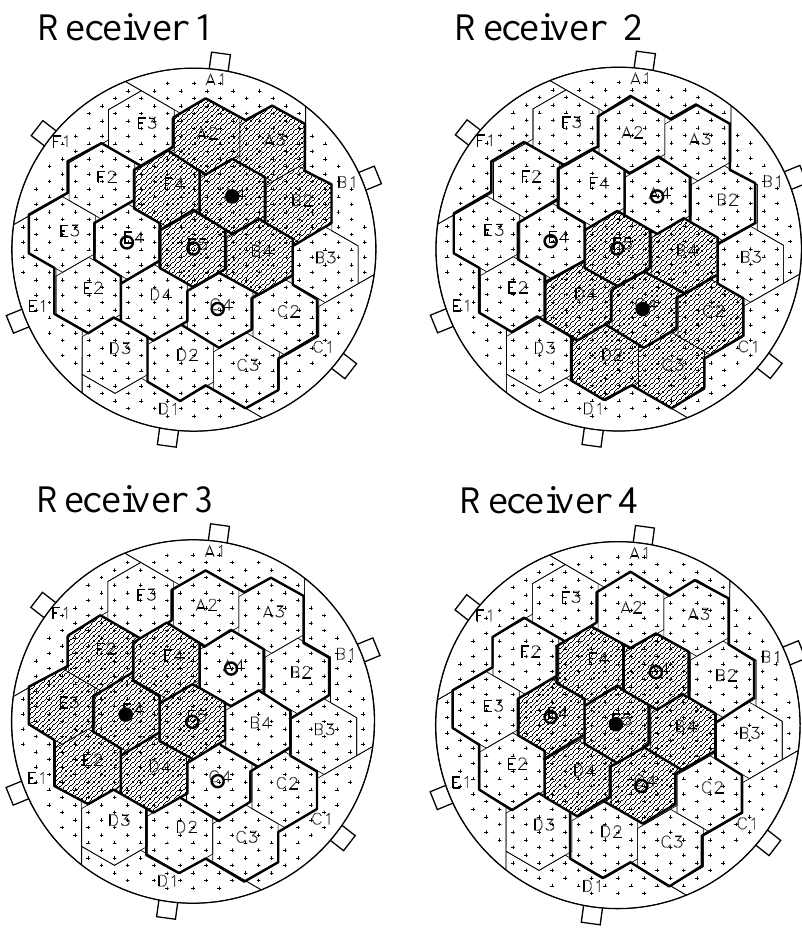
Fig. 1. A schematic depiction of N = 4 receiving antennas for the MUR experiment on 24 April 2002. Each receiver is shown by shading and consists of 7 groups, 19 Yagis per group. In each drawing, the receiver’s center is indicated by a bullet while circles show centers of the other three